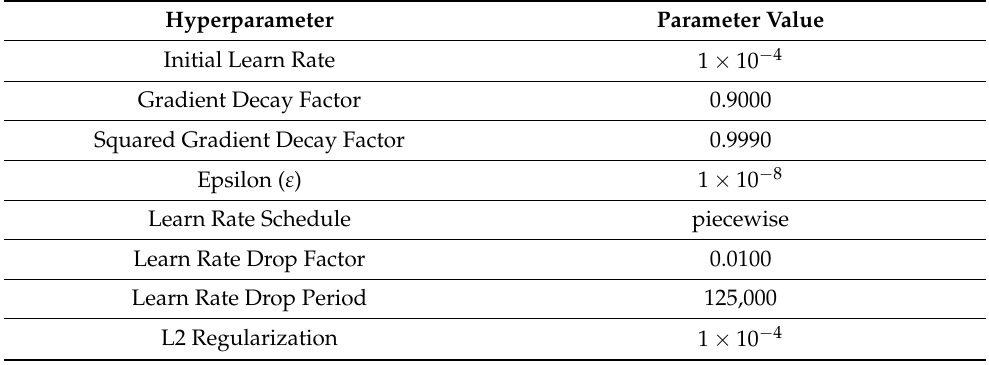
Table 3. Details of the implemented context aggregation